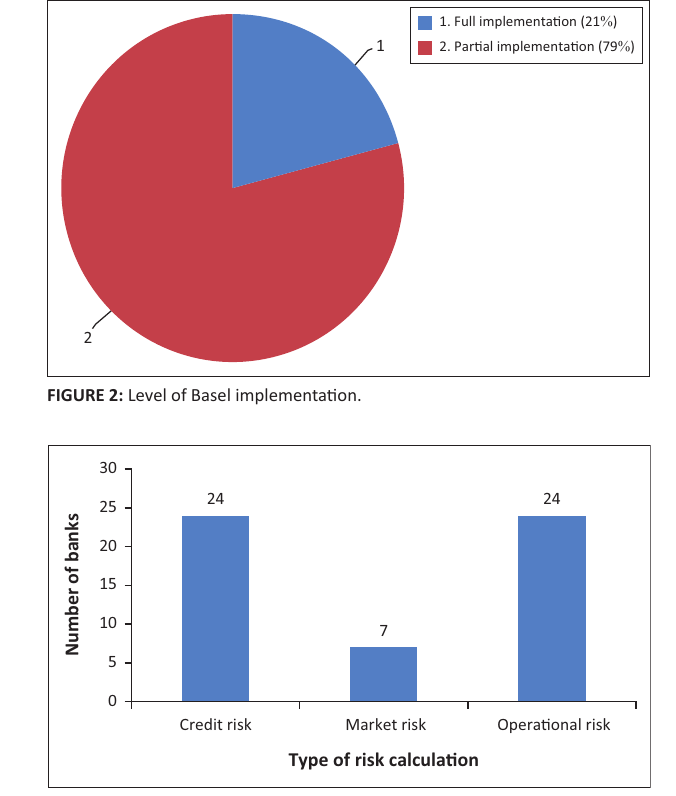
Figure 2 indicates the level of implementation in participating banks.